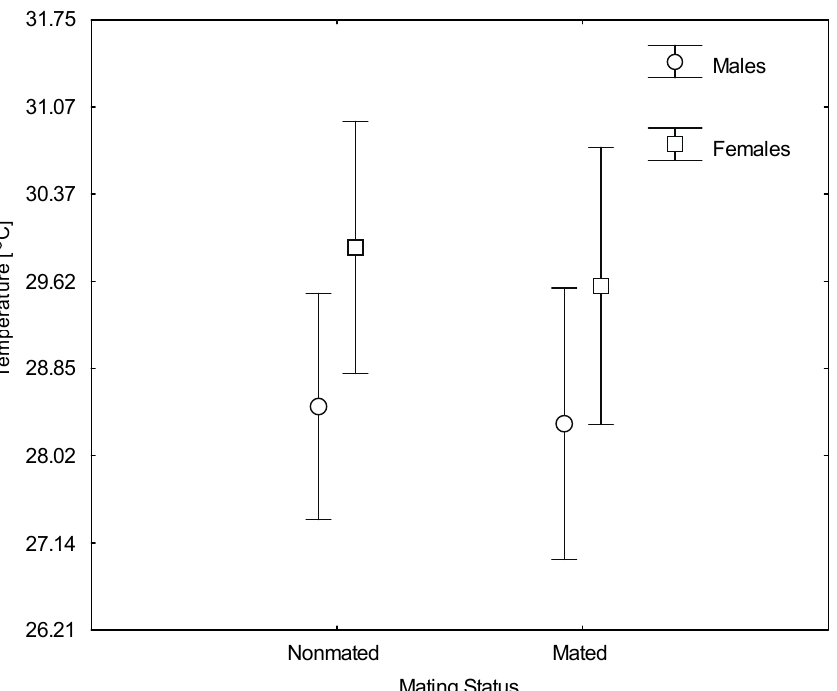
Figure 2. The effect of sex and mating status (nonmated—virgin individuals; mated—virgin individuals that were allowed to mate once) on the preferred temperature of Callosobruchus maculatus beetles. Vertical bars denote 95% confidence intervals (see Table 1). In the statistical model, the temperature data were cube-transformed, but they were back-transformed for presentation purposes. Note that only the effects of sex were significant. Table 1. The results of two general linear models of preferred temperatures of Callosobruchus macu- latus beetles, without and with body mass as a covariate. Mating status represents either non- mated beetles (virgin individuals) or mated beetles (virgin individuals that were allowed to mate once).